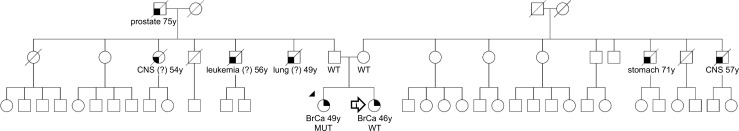
Pedigree of family 8.The white arrow indicates the phenocopy 8-i; the black arrowhead indicates the family proband (i.e. the first tested family member), carrier of the de novo BRCA2 mutation c.771_775delTCAAA (p.Asn257Lysfs*17). Genetic analysis results (MUT, mutation carrier; WT, wild-type) are reported beneath tested individuals; neoplastic diseases and age at diagnosis in years (y) are reported beneath affected individuals. BrCa, breast cancer; CNS, central nervous system;?, uncertain data.